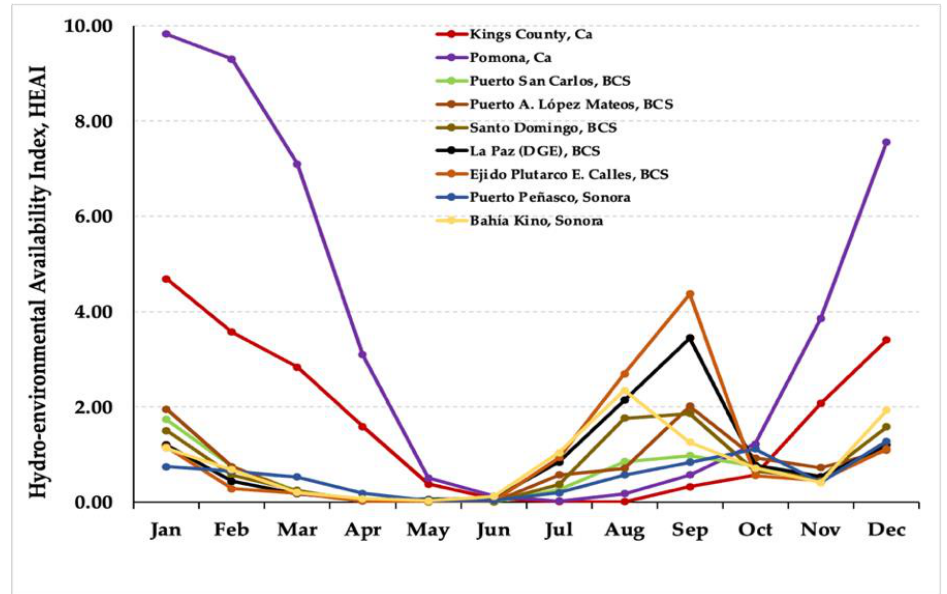
Figure 7. Historical data of the Hydro-Environmental Availability Index (HEAI) from nine stations in NW Mexico (Baja California Sur and Sonora) and the SW region of the USA (California), where several species of Suaeda are reported.